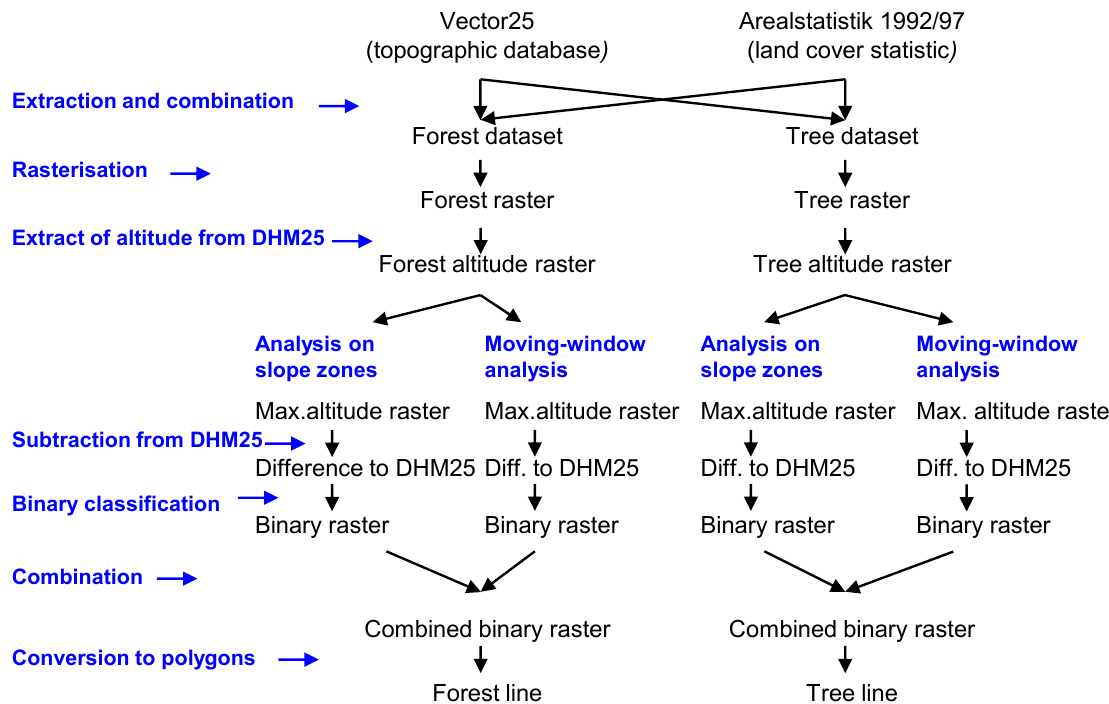
Figure 4. The data flow diagram lists the intermediate products (black) and the processes (blue) of the analysis. The topographic database Vector25 (Swisstopo 2009) and the land cover statistic Arealstatistik 1992-1997 (BFS 2001) served as data sources. The digital elevation model DHM25 (Swisstopo 2001) was used to assign the altitude to the forest and the tree raster cells and to delimit the area above and below the maximum altitude of forest and